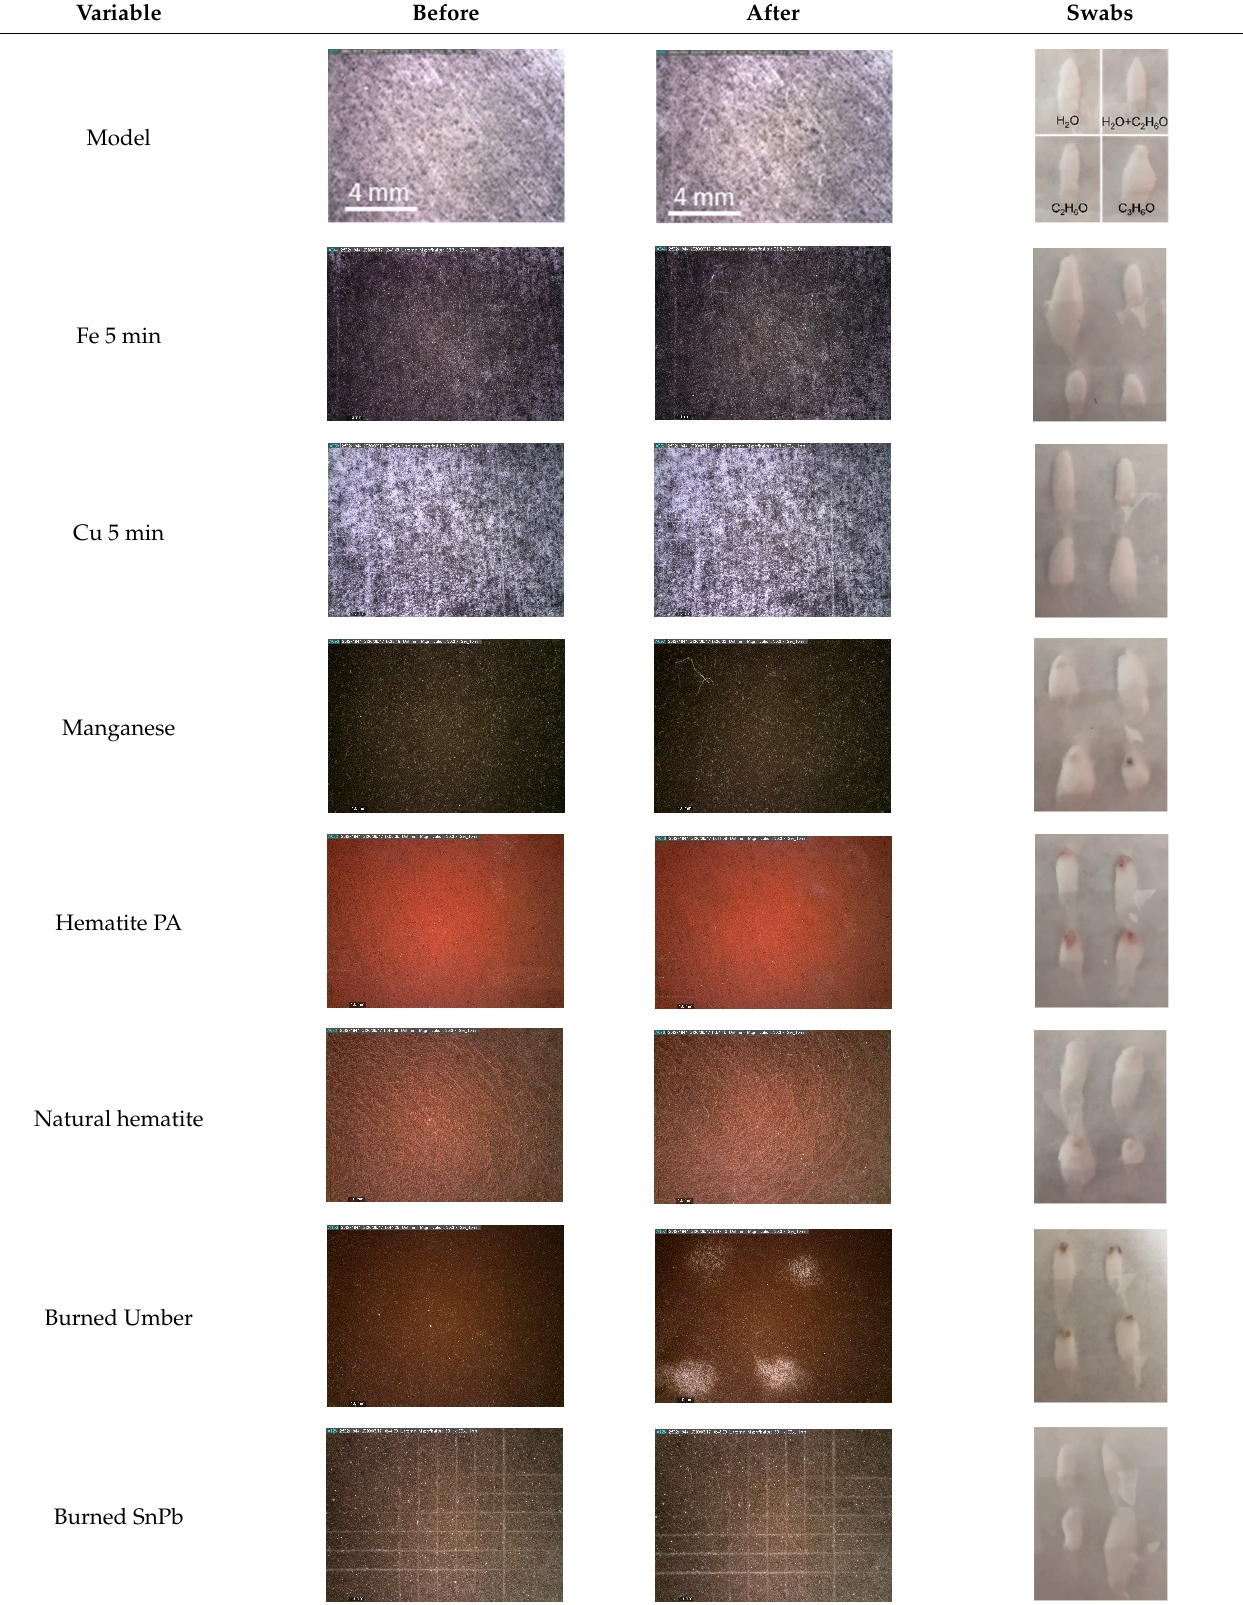
Table 7. Results from the cleaning test.